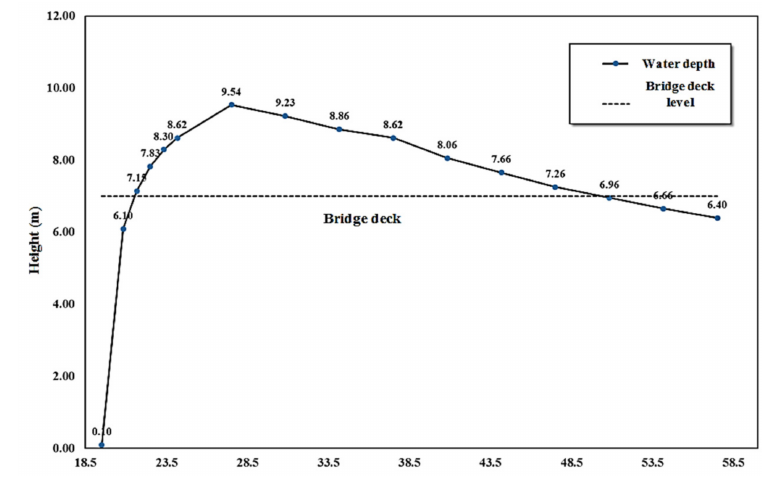
Figure 21. Water level variations at the B2